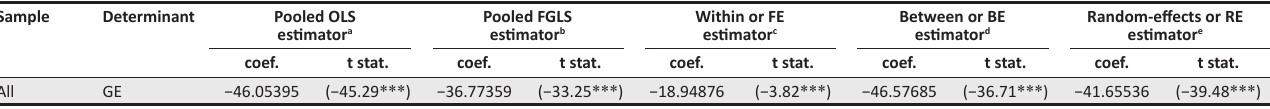
TABLE 8: Variation of Corruption Perceptions Index depends on government effectiveness, by stage of development: All. Sample